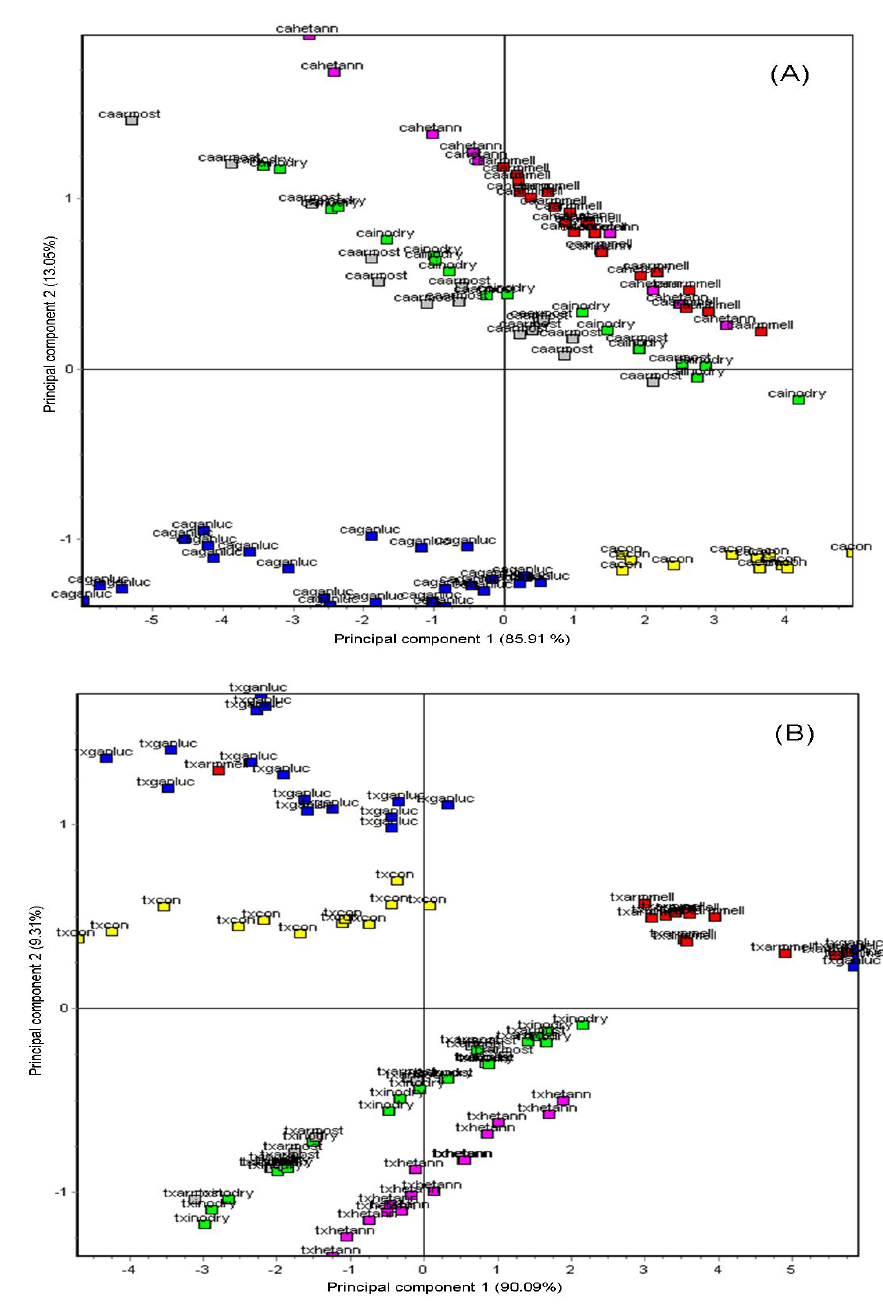
Figure 4. Aroma map plot showing discrimination of volatiles from decayed wood samples of (A) Celtis australis , (B) Tilia spp. and (C) Acer negundo by principal component analysis (PCA) of mean changes in crystal oscillation-frequency ( Δ f) data. Different color labels 1 indicate different wood decay fungi responsible for decay and corresponding headspace volatiles produced. The first two letters of each label indicate specific tree species according to the following abbreviations: ca = Celtis australis ; tx = Tilia sp.; an = Acer negundo . The subsequent letters following in the label indicate the wood decay fungus responsible for decaying the wood blocks for 12 months following artificial inoculation: ganluc = Ganoderma lucidum : hetann = Heterobasidion annosum ; armmell = Armillaria mellea ; armost = A. ostoyae ; inodry = Inonotus dryadeus . Con = undecayed or healthy (control) wood